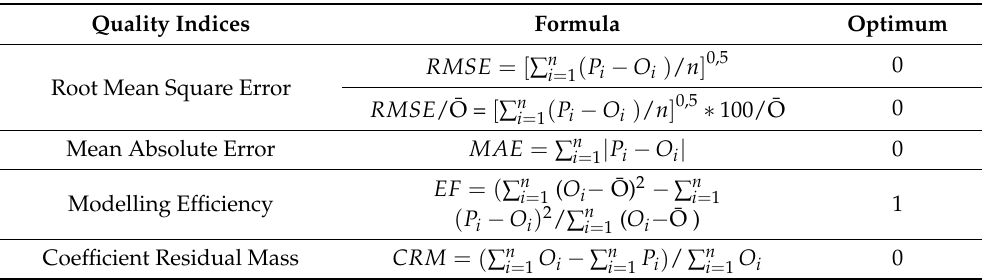
Table 1. The indices used to evaluate the goodness of fit (P i = estimated values, O i = observed values, Ō = the average of observed data, and n = number of the observations).